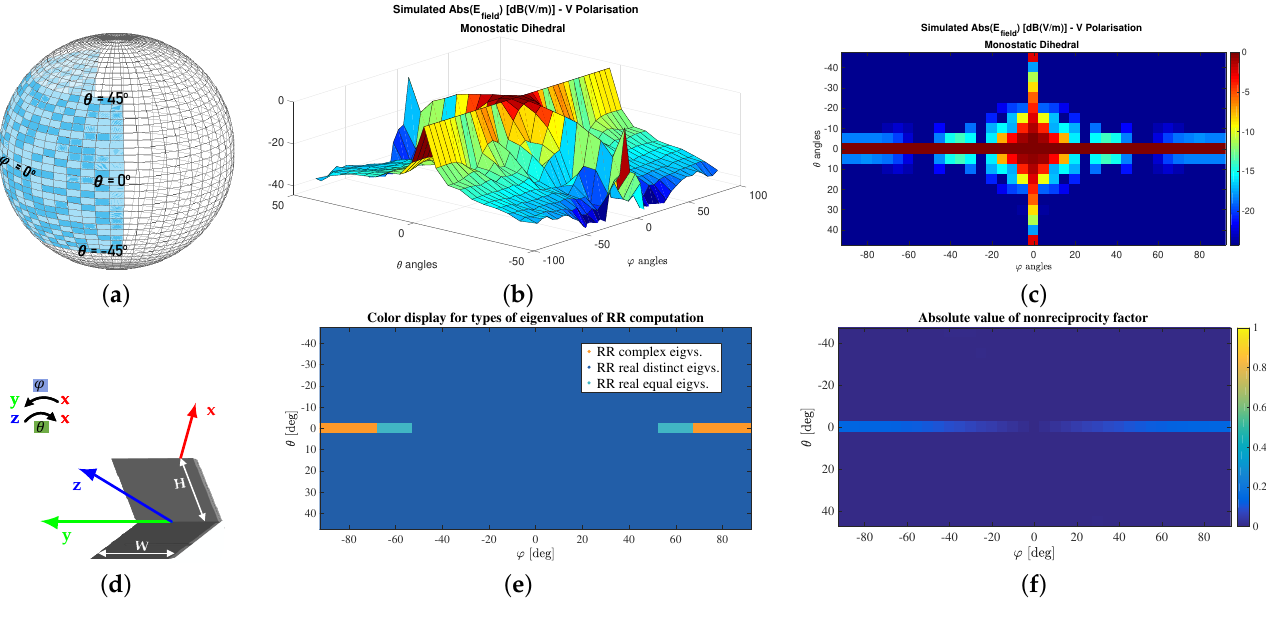
Figure 5. 90 ◦ Dihedral. ( a ) Range of incidence/scattered spherical positions for the monostatic simulations. Normalized absolute value of simulated scattered electric far-field E s ( b ) Vertical polarization, 3D. ( c ) Vertical polarization, 2D. ( d ) Dihedral representation in the general coordinate system. ( e ) Colormap display for RR eigenvalues classification of the dihedral’s monostatic response, for observation directions in the investigated range. ( f ) Modulus of the nonreciprocity factor for the dihedral’s monostatic response for observation directions in the investigated